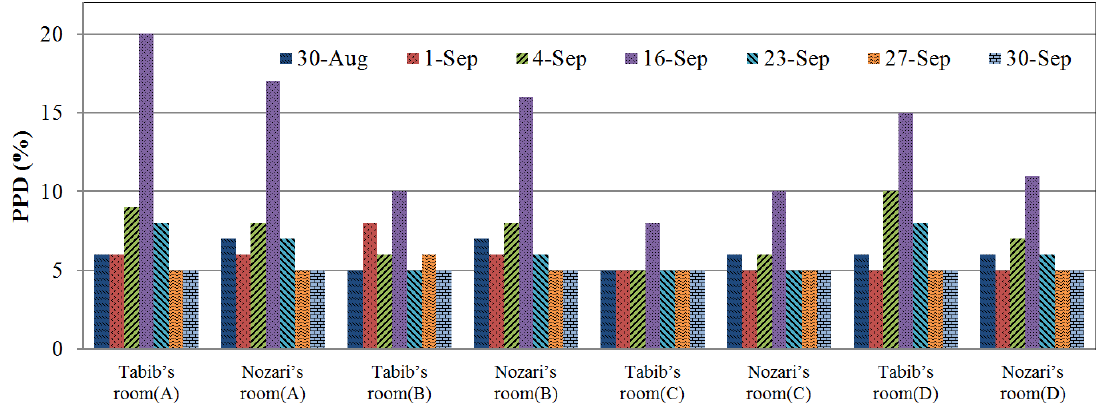
Figure 20. Predicted Percentage of Dissatisfied (PPD) index of the rooms during test days (August 30 and September 1, 4, 16, 23, 27, and 30, 2016).